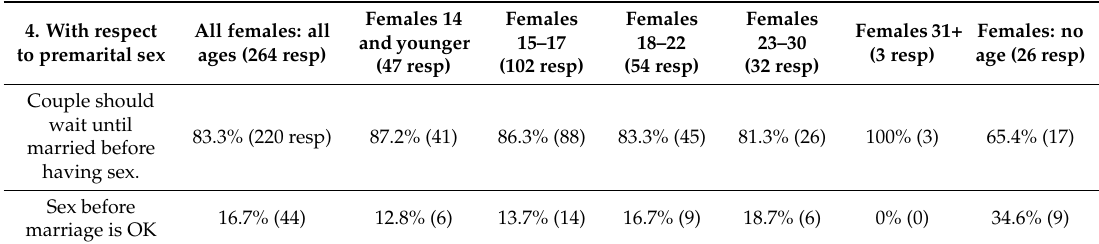
Table 10. Attitudes about Premarital Sex—All